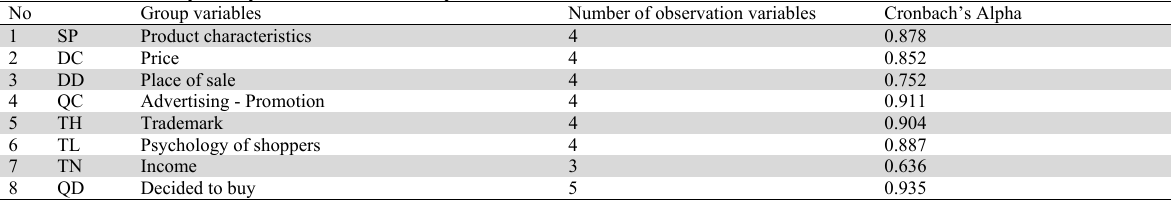
Results of reliability analysis and factor analysis